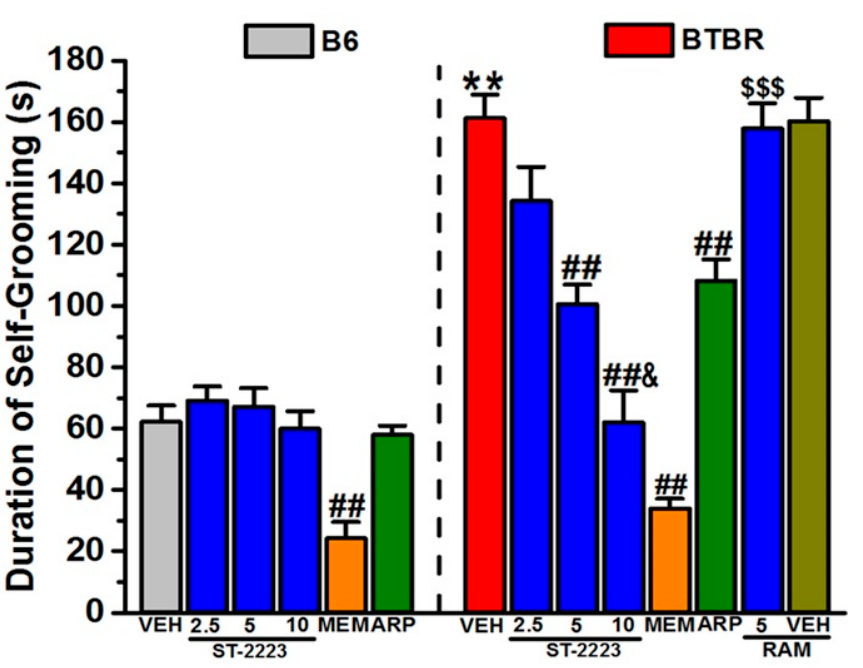
Figure 3. ST-2223 treatment mitigates spontaneous self-grooming behavior in BTBR mice. Self- grooming behavior was measured in B6 and BTBR mice. Each mouse received an i.p. injection of vehicle, ST-2223 (2.5, 5.0, or 10 mg/kg, i.p.), MEM (5 mg/kg, i.p.), or ARP (1 mg/kg, i.p.) 30–45 min prior to self-grooming behavior assessment. BTBR mice spent significantly more time grooming compared to that of B6 mice. Vehicle, ST-2223, MEM, or ARP treatment did not affect spontaneous self-grooming behavior in B6 mice. ST-2223 (5 and 10 mg/kg, i.p.), and MEM (5 mg/kg, i.p.) signifi- cantly decreased self-grooming behavior in BTBR mice. ARP (1 mg/kg, i.p.) failed to significantly alter the increased self-grooming behavior of BTBR mice. Effects systemic co-injection of ( R )- α - methylhistamine (RAM, 10 mg/kg, i.p.) on the ST-2223 (5 mg)-induced decrease in self-grooming behavior of BTBR mice were also assessed. Data are expressed as the mean ± SEM time spent groom- ing all body regions ( n = 5). ** p < 0.01 vs. vehicle-treated B6 mice. ## p < 0.01 vs. vehicle-treated BTBR mice. & p < 0.05 vs. ST-2223 (5 mg)-treated BTBR mice. $$$ p < 0.001 vs. ST-2223(5 mg)-treated BTBR